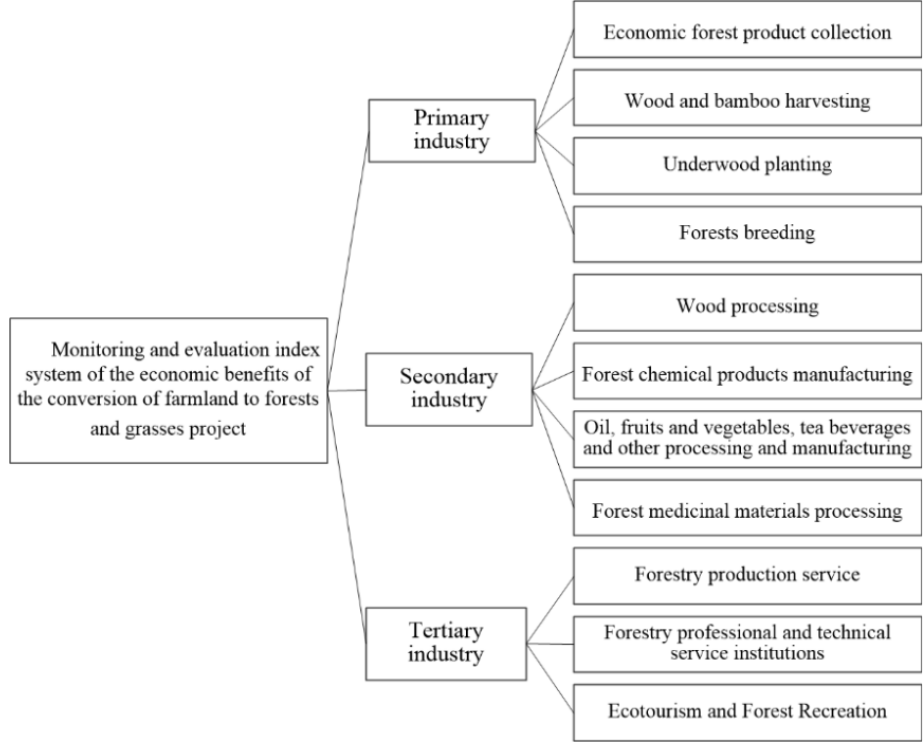
Figure 2. Monitoring and evaluation index system of the economic benefits of the CFFG project.